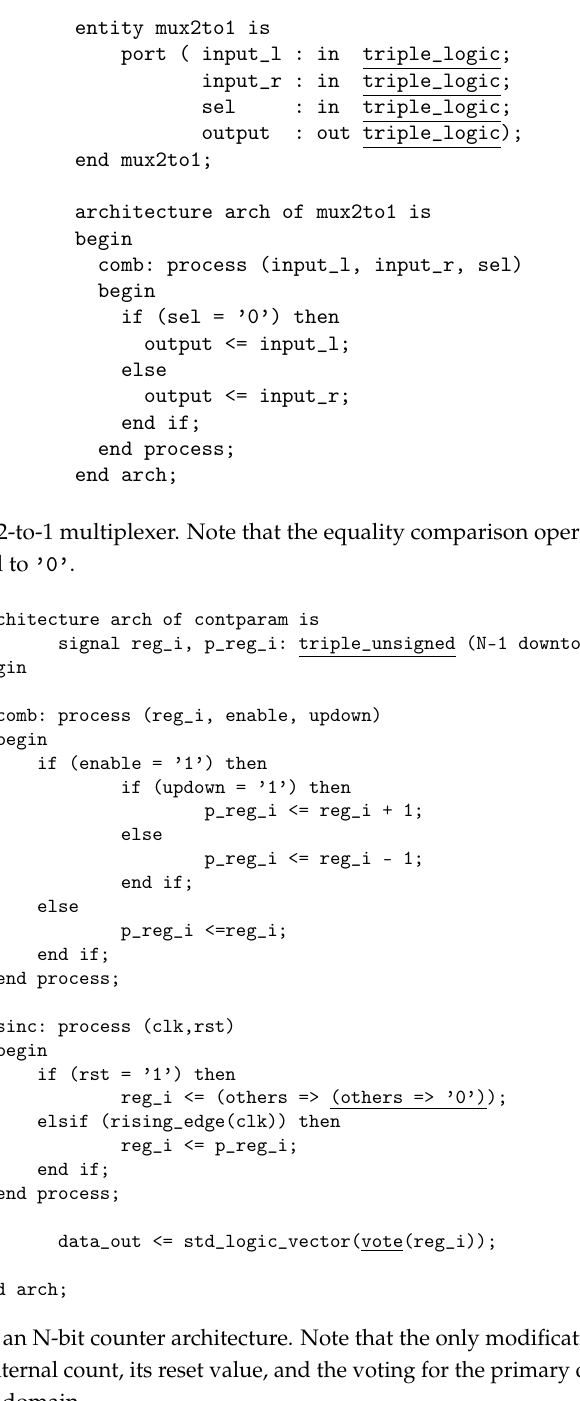
Figure 6. Hardening an N-bit counter architecture. Note that the only modifications are the change in to the non-hardened